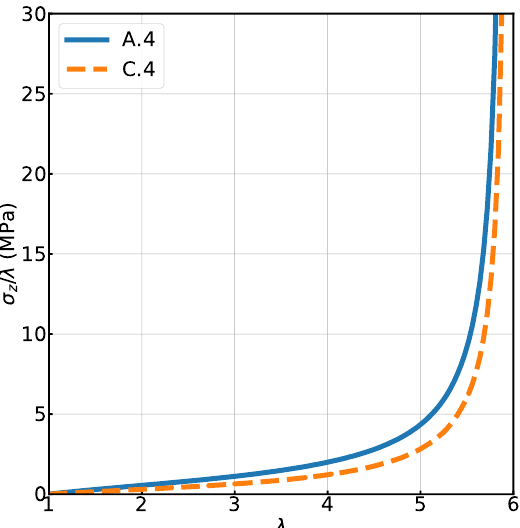
Figure 8. Comparison of the load versus stretch diagrams (uni axial deformation) of the two different 4 chain